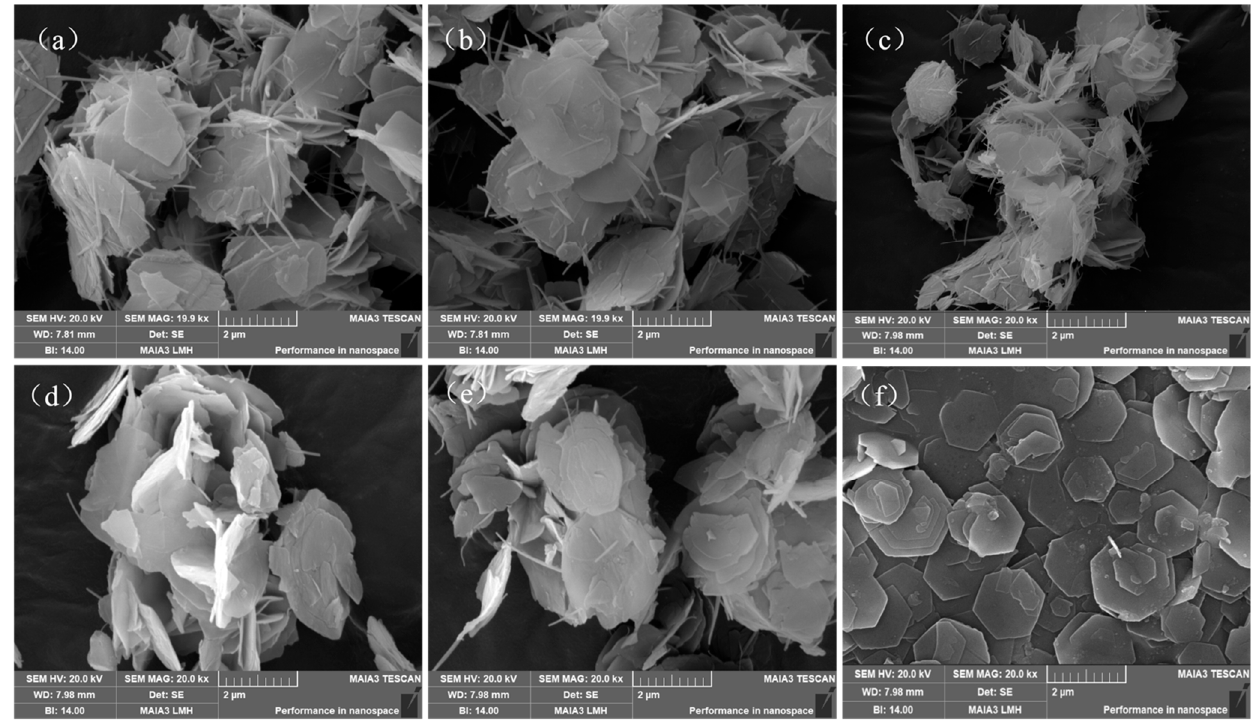
Figure 12. SEM images (( a ): M1-Zn; ( b ): M3-Zn; ( c ): M2-Cu; ( d ): M5-Cu; ( e ): M5-Fe; ( f ): M6-Fe). Table 3. Rheological properties of the 4% samples at room